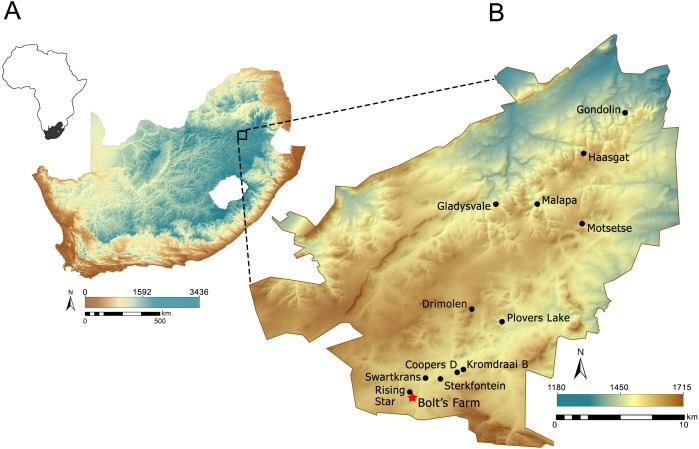
Location of the Cradle in South Africa (A) and Bolt’s Farm within the Cradle (B). Elevation data made available from Jarvis et al. (2008).